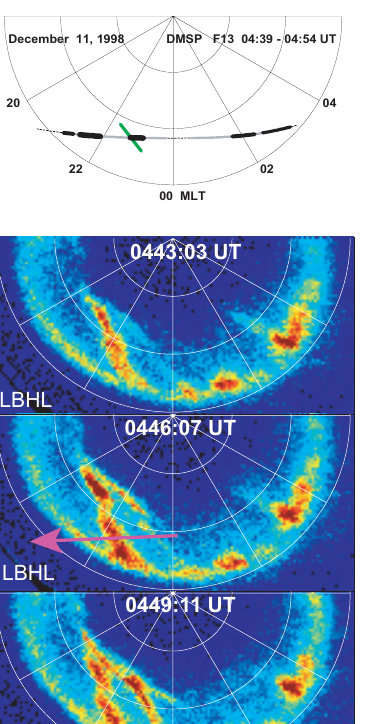
DMSP spectrogram shows the strongest intense (EF exceed- ing 10 13 eV/cm 2 sr), narrow ( 1t ∼ 6 s gives L x ∼ 40 km) pre- cipitation at the corresponding location. Associated with it is a depressed proton precipitation, so it also belongs to the Type 1 category. Its association with very intense FAC ( j k > 7 µ A/m 2 , with some data gaps) is also very clear. As distinct from the previous case, this streamer is observed at the dusk flank of a single, powerful stream of equatorward convection, which is rather wide ( L x ∼ 350 km) and strong ( V y > 1 km/s). Such a pattern is consistent with the scheme shown in Fig. 1. ( V x has a data gap over the convection stream region and is not shown.) The DMSP encountered this streamer in the middle of the active auroral oval, which was ∼ 7 ◦